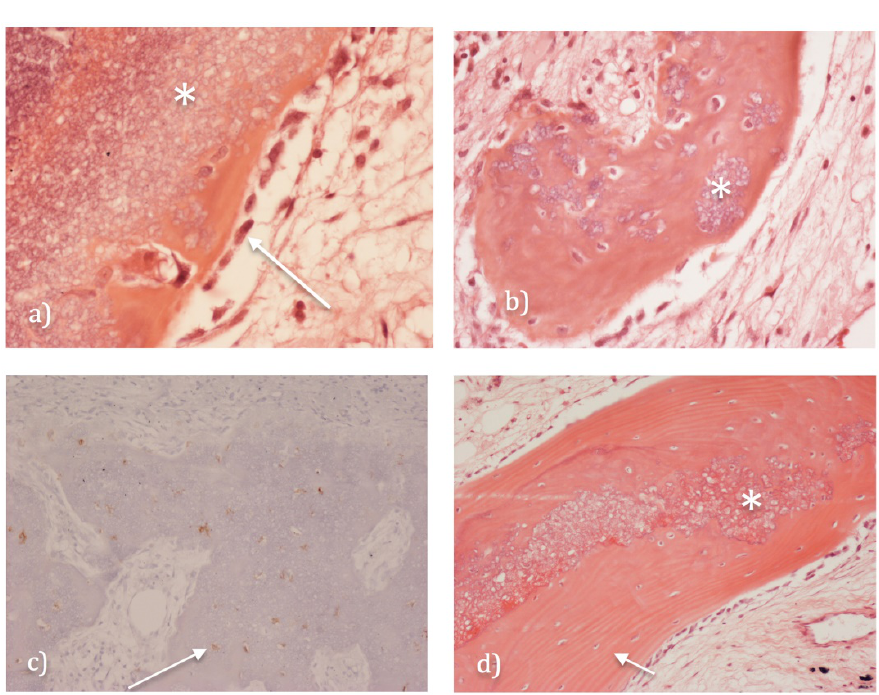
Figure 4 . Histology of CERAMENT®|G (A) an early biopsy showing CERAMENT®|G (see asterisk) covered by an osteoid-like matrix produced by osteoblastic cells seen lining the gBGS surface (see arrow). (B) shows focal mineralisation of the osteoid matrix and early woven bone formation around the residual gBGS (see asterisk). (C) immunohistochemistry demonstrating osteocytes in woven bone (brown staining) around the gBGS, expressing dentine matrix protein-1 (DMP-1) and podoplanin (see arrow). (D) later biopsy (at 2 years) demonstrating BSG particles (see asterick) incorporated into formed lamellar bone trabeculae (see